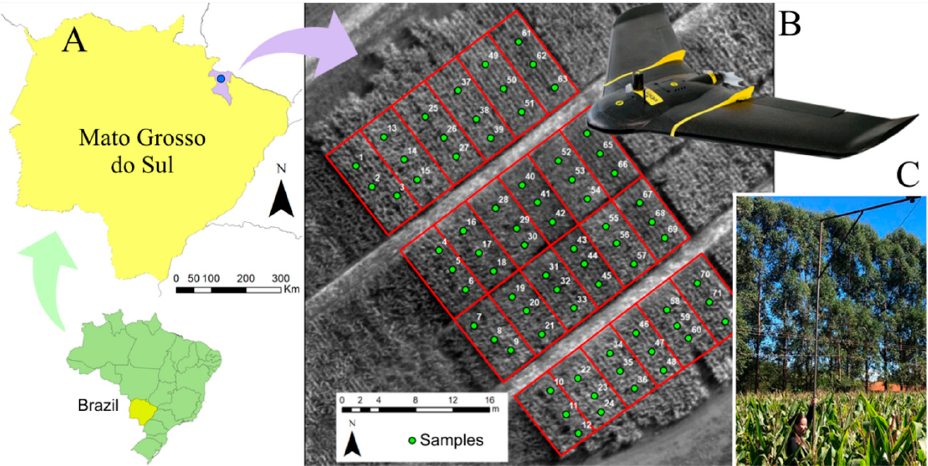
Figure 1. Location of the municipality of Chapadão do Sul/Brazil ( A ), illustration of the experimental field and UAV used ( B ), and measurement of the temperature of the maize crop canopy ( C ). Table 1. Information on soil pH, organic matter, phosphorus, aluminum, potassium, calcium and magnesium, CEC, base saturation (V%), and clay content.